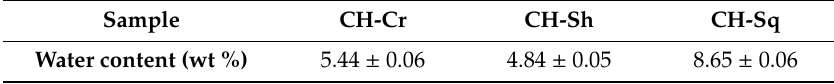
Table 2. Water content of CH extracted from di ff erent sources.